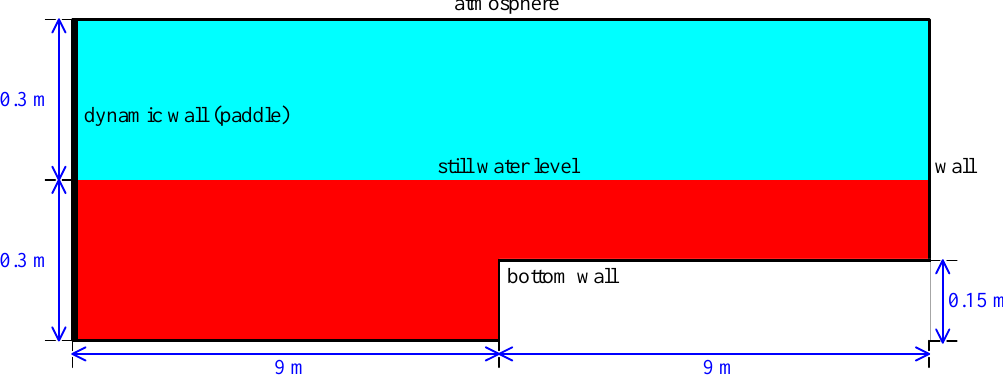
Figure 11. An illustration of the computational domain with a step.